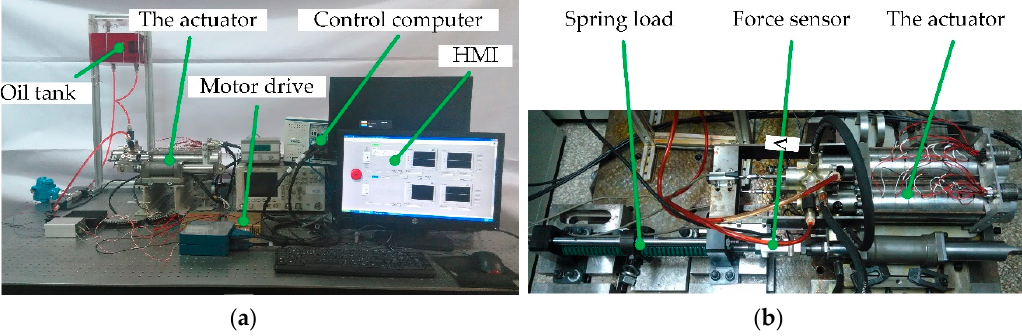
Figure 12. The actuator test rig: ( a ) the overall test rig with the actuator control system; ( b ) the actuator output force testing configuration.